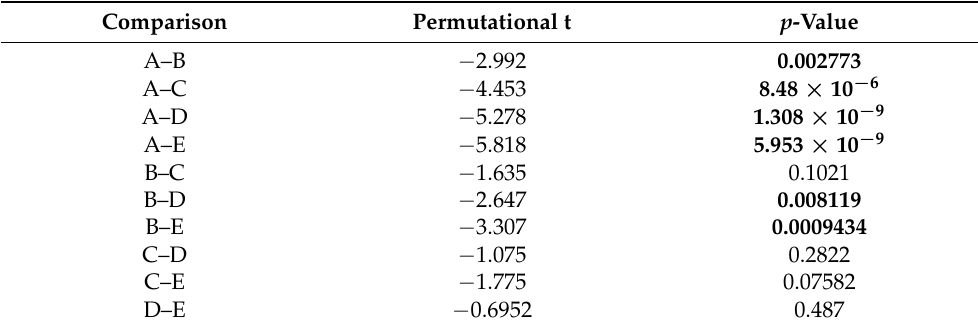
Table 4. Factor 1 (Time) pairwise permutational t -test outcome for the trajectory convex hull area. A = one minute of recording; B = two minutes of recording; C = three minutes of record- ing; D = four minutes of recording; E = five minutes of recording. Statistically significant results in